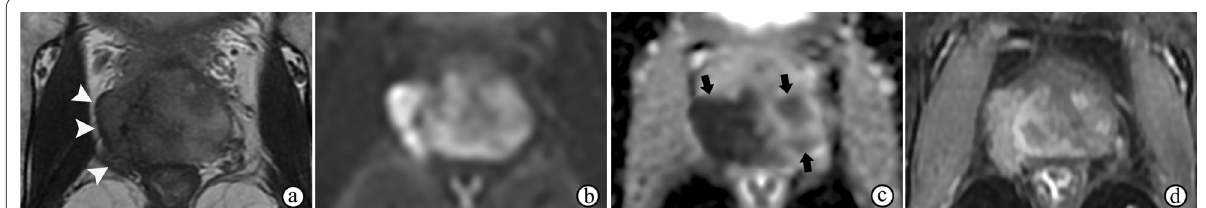
Fig. 2 Nonspecific granulomatous prostatitis in a 57-year-old male who experienced frequency, urgency and burning micturition for 1 month, with a serum PSA level of 18.67 ng/mL transiting to 5.04 ng/mL. a–c T2WI, DWI at a b-value of 1400 s/mm 2 and ADC maps show a diffusely and multifocally low signal intensity in the surrounding parenchyma on T2WI ( a ), a high signal intensity on DWI ( b ) and low ADC values (arrows on c in the prostate, with extraprostatic extension (arrowheads on a ). ( d ) DCE imaging shows diffuse and multifocal areas of enhancement. The abnormal appearances of the prostate in the images shown in a–d result in a PI-RADS score of 5